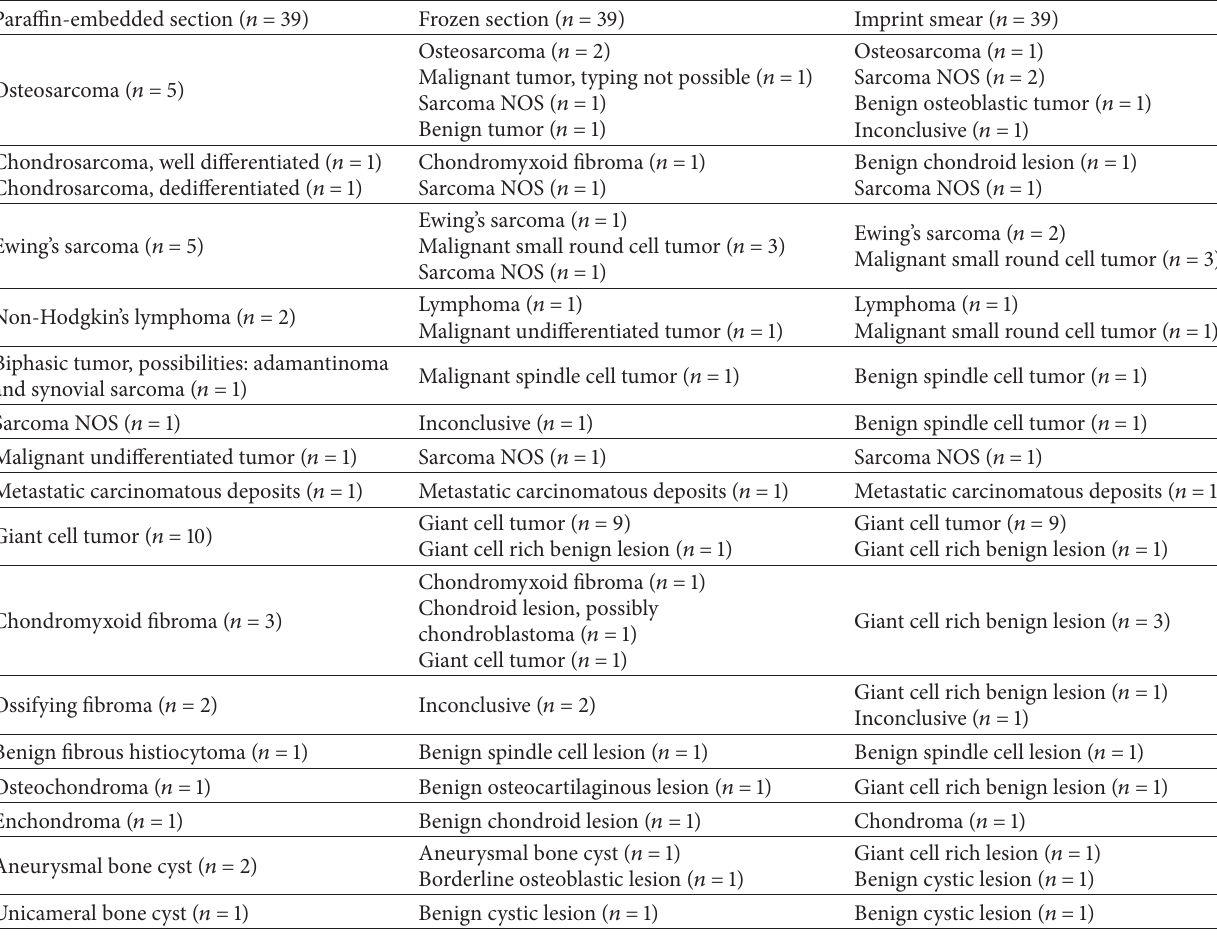
Table 1: Correlation of frozen section and imprint cytology with paraffin-embedded sections ∗ .